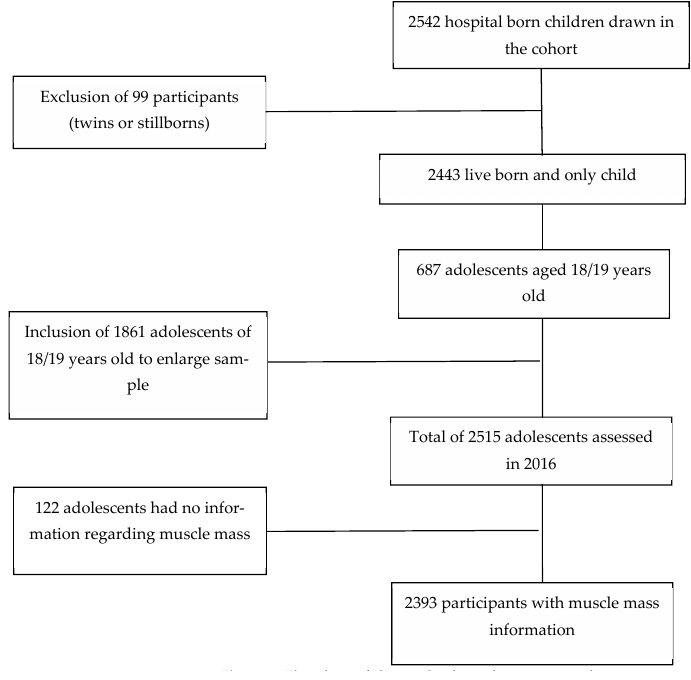
Figure 1. Flowchart of this study about the association between sugar-sweetened beverages and muscle mass index, Sao Luis, Brazil, 2016.